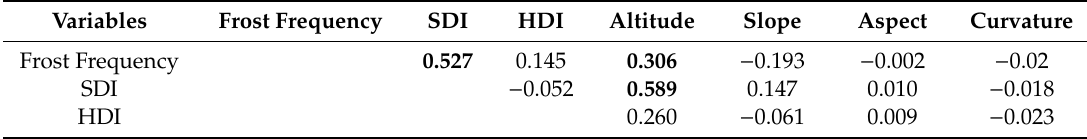
Table 2. Spearman’s statistical correlation analysis (r s ) among frost frequency, SDI, HDI and topography. Variables Frost Frequency SDI HDI Altitude Slope Aspect Curvature Frost Frequency 0.527 0.145 0.306 − 0.193 − 0.002 − 0.02 SDI − 0.052 0.589 0.147 0.010 − 0.018 HDI 0.260 − 0.061 0.009 −